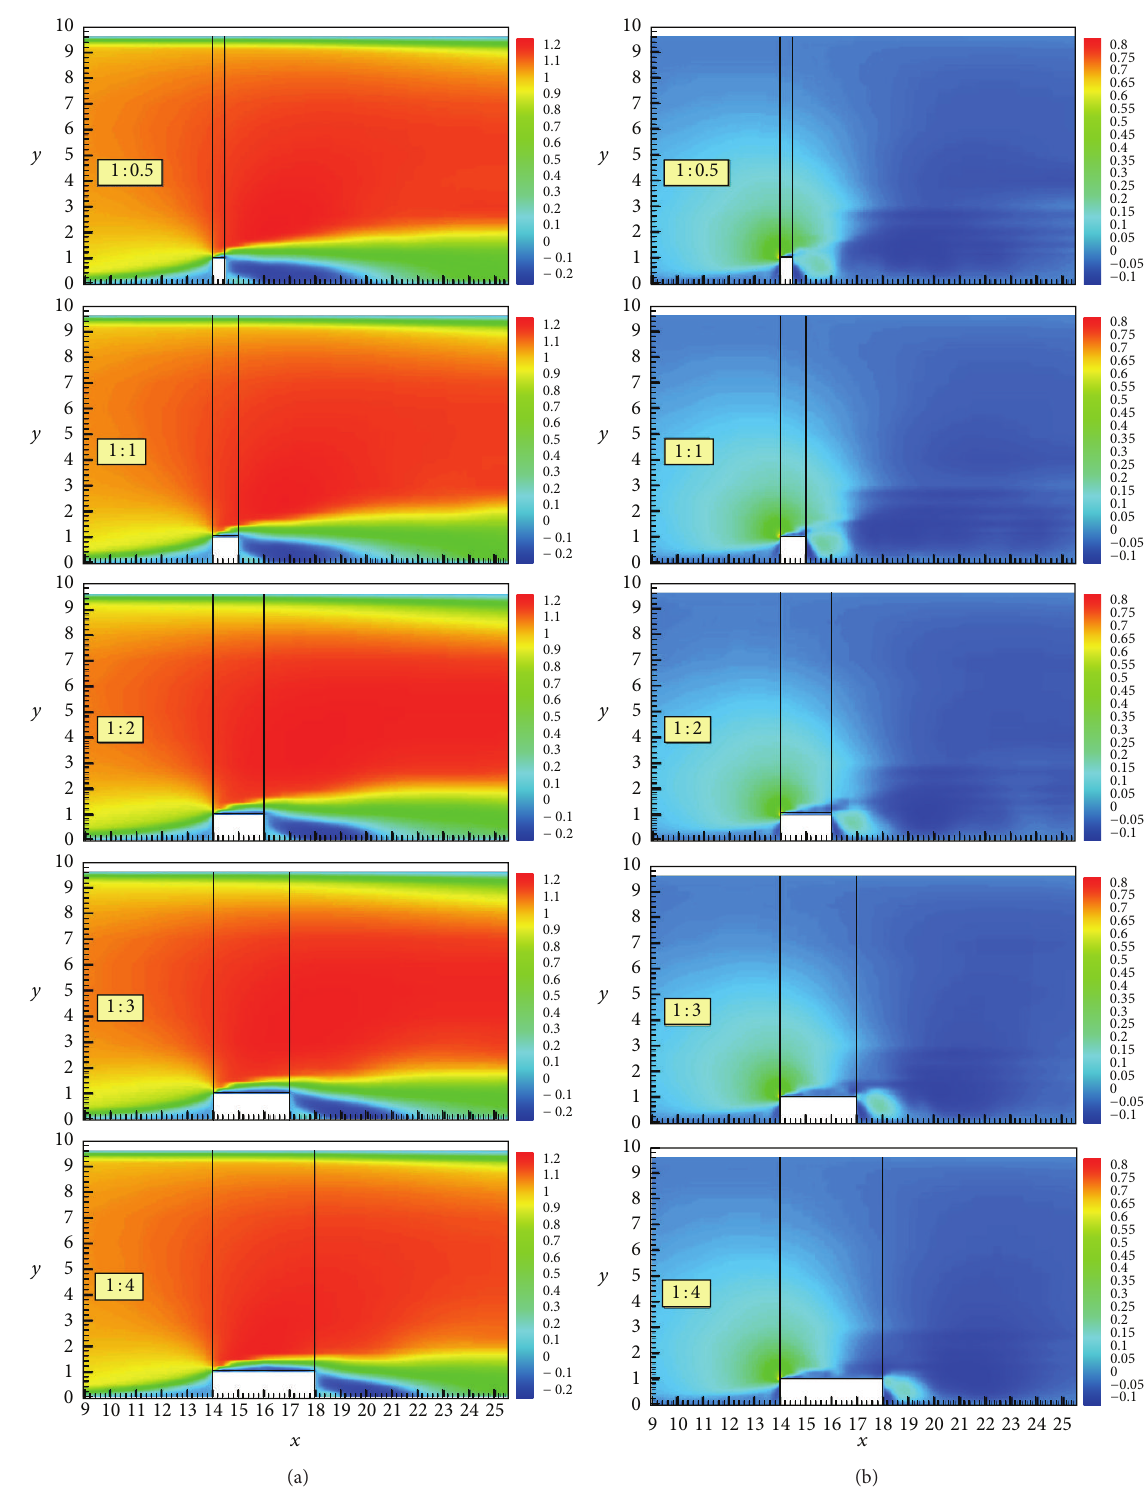
Figure 6: Color-coded plots of streamwise mean velocity ⟨𝑈 1 ⟩ (a) and transverse mean velocity ⟨𝑈 2 ⟩